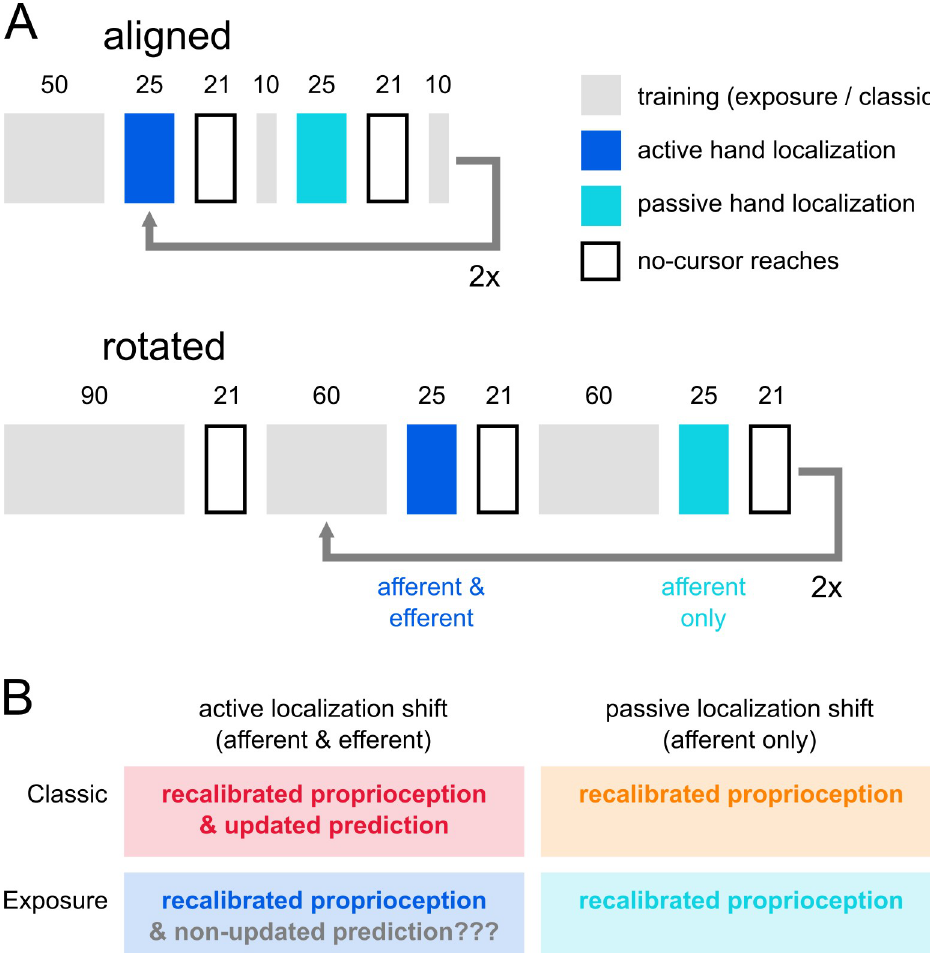
block in the rotated session, to assess decay. The number of trials (numbers above the rectangles) in the no-cursor reaching tasks and both types of localization were the same in the aligned and rotated sessions, but while aligned training was kept to a minimum, rotated training was increased to ensure sufficient adaptation. The exposure training group did passive and active localization twice, but the classic training group did different localization tasks in the second half of each session, the data of which is not used here. b) Our main question was about the signals contributing to hand localization in the four different kinds of localization. According to our hypothesis, updated predicted sensory consequences should have only contributed to active hand localization after classic